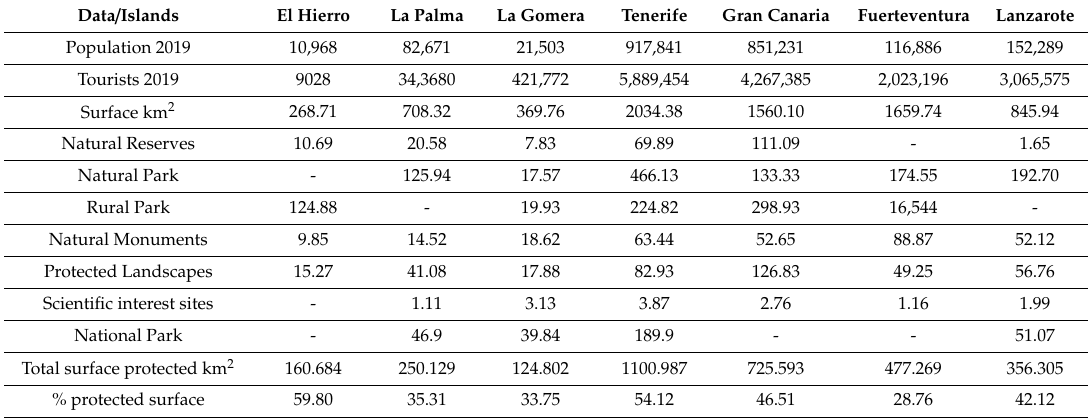
Table 2. Inhabitants, tourists and surface of the regional and national protected areas of Canary Islands. Data /